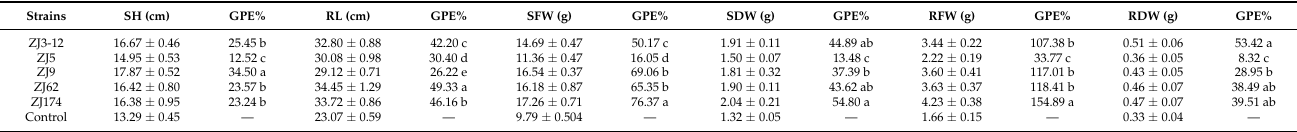
Table 3. Effect of five PGPB strains on growth promotion of eggplant plants at 30 d after bacterial inoculation.